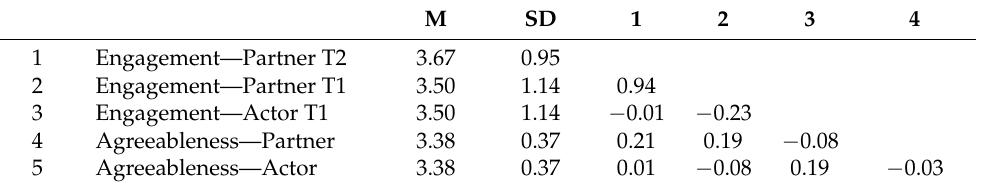
Table 1. Descriptive statistics and correlations for all variables used (N =